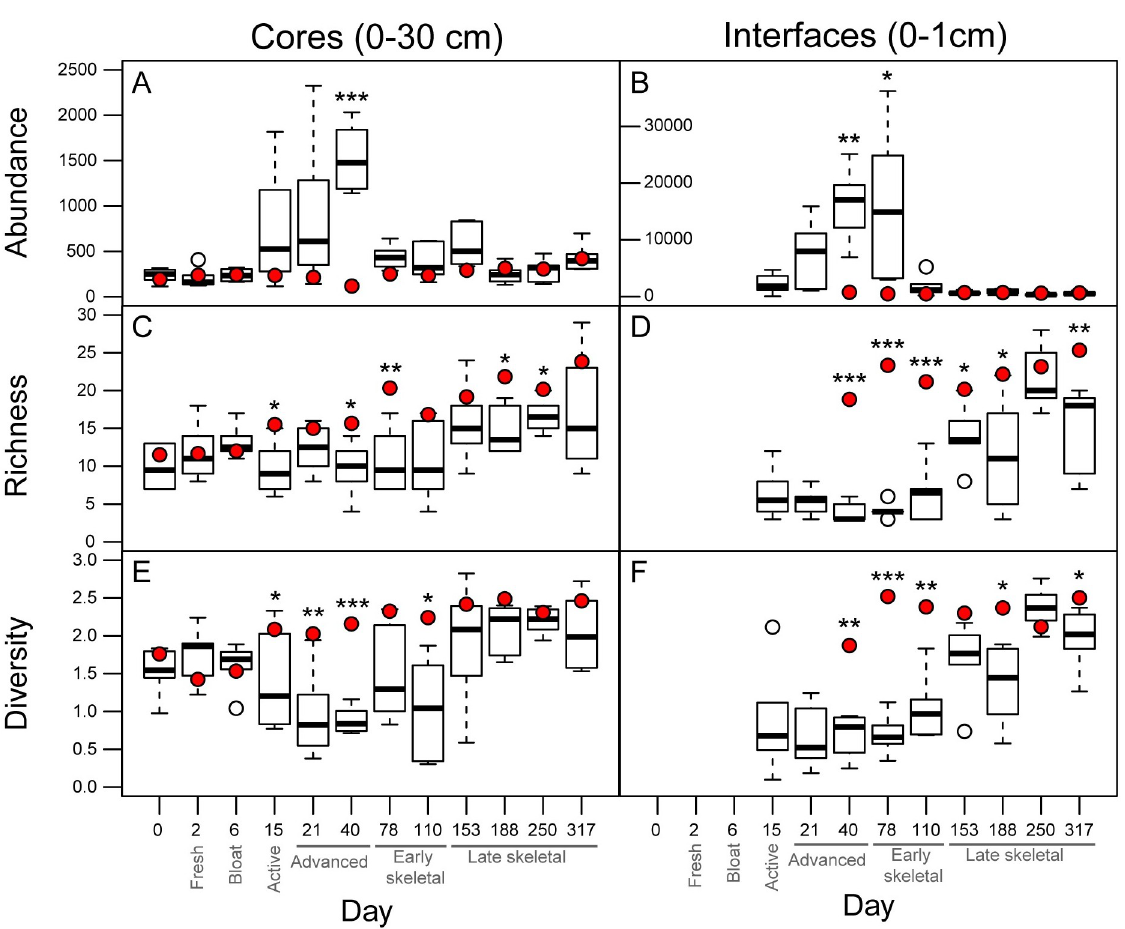
Fig 2. Nematode abundance, richness, and diversity. (A-B) Nematode abundances, (C-D) richness, and (E-F) Shannon diversity (E-F) found in core (0–30 cm) and interface (0–1 cm) soils. Control means are represented by red dots. Interface data collection began on day 15, and interface control data collection began on day 40. Boxes display 25th and 75th quartiles and medians; whiskers display ± 1.5 quartiles.